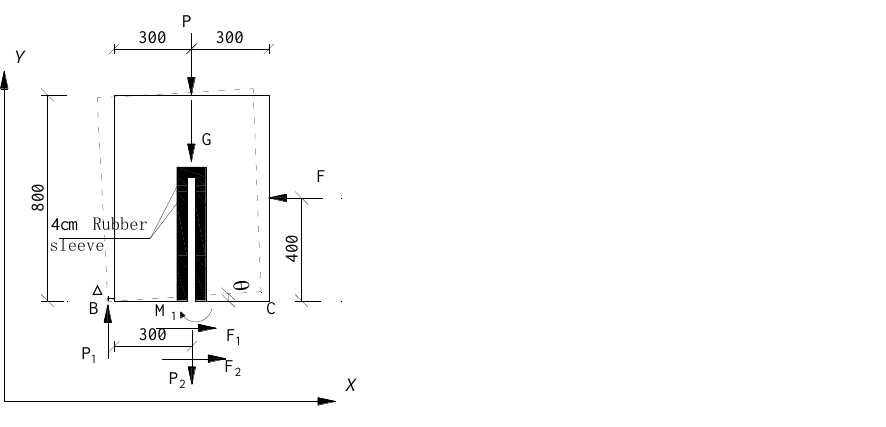
Figure 12. Isolator for calculation of force on the joint (unit: mm).